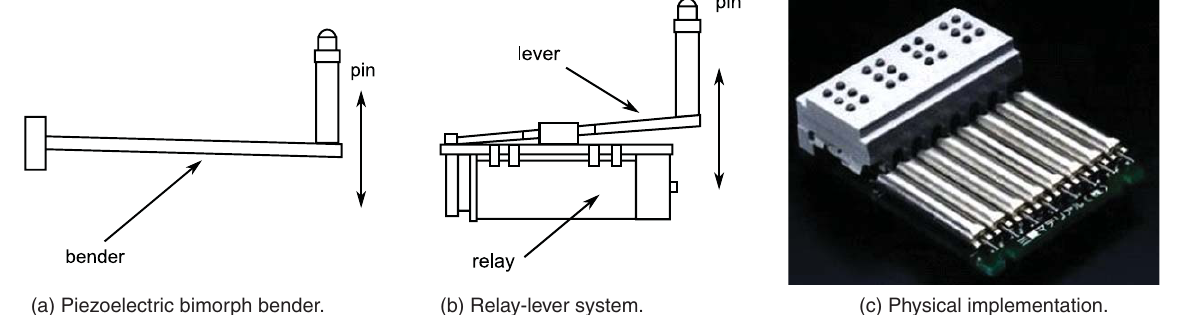
Fig. 3. Examples of existing Braille